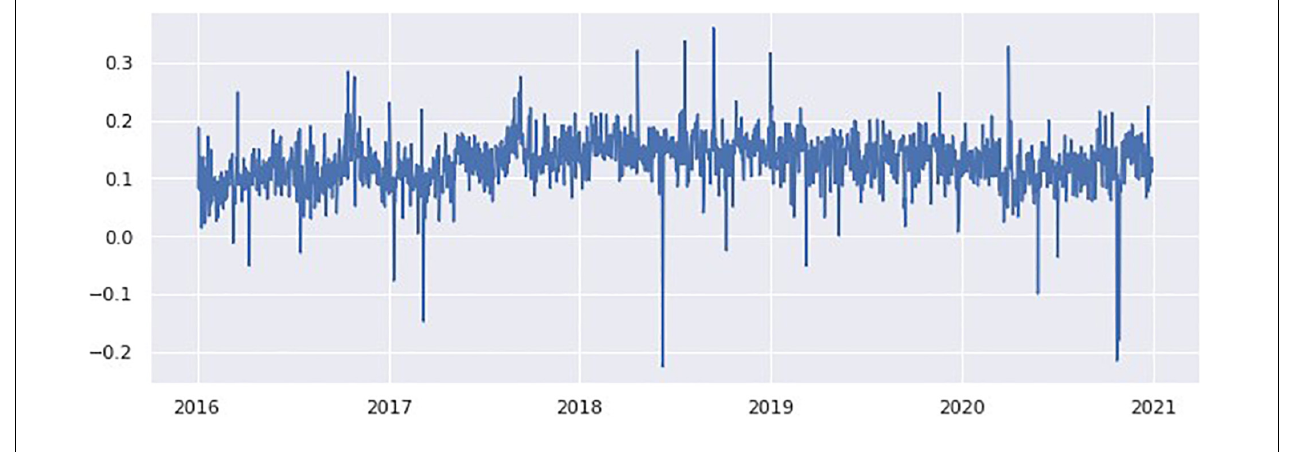
FIGURE 11 | Public sentiment of tweets on ESG with timeline. TABLE 4 | Examples of tweets from days when positive and negative sentiment